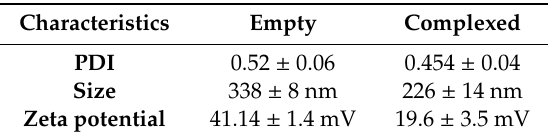
Table 1. Physio-chemical characteristics of empty NP (nanoparticles without P10) and complex NP (nanoparticles complexed with 20 µ g / 10 µ L of P10